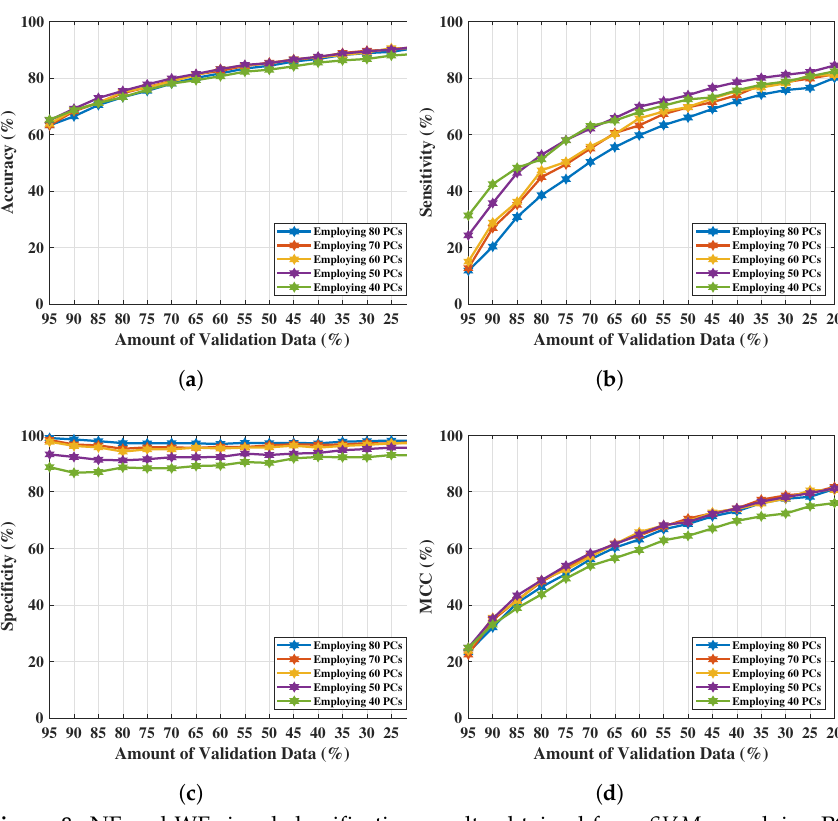
Figure 8. NF and WF signal classification results obtained from SVM G applying PCA over real- parts of MammoWave’s complex S 21 data. ( a ) Accuracy obtained from SVM G varying PCs and validation data. ( b ) Sensitivity obtained from SVM G varying PCs and validation data. ( c ) Specificity obtained from SVM G varying PCs and validation data. ( d ) MCC obtained from SVM G varying PCs and validation